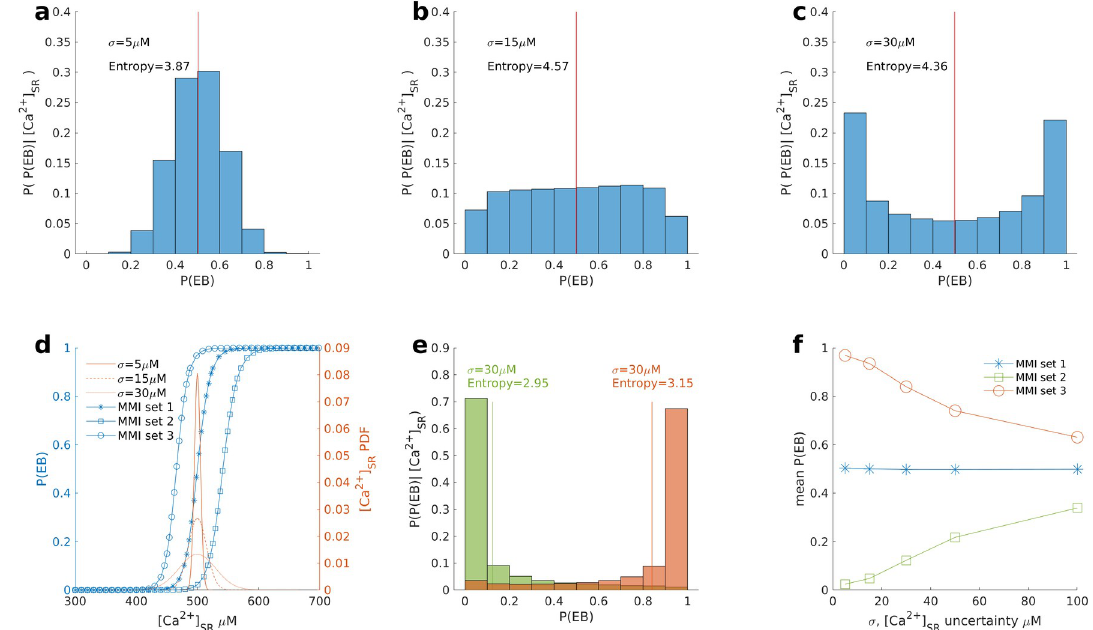
Fig 3. Uncertainty analysis of P(EB) due to variation in [Ca 2+ ] SRini . Three MMI sets are used. All MMI sets have [Ca 2+ ] iini = 150 nM, [Ca 2+ ] SRini = 500 μ M, and k RyR+ _sf = 1. G K1 _sf for set 1, set 2, and set 3 is 0.338, 0.638, and 0.000, respectively. The P(EB) distributions given different hypothetical [Ca 2+ ] SRini uncertainties ( σ ) of set 1, where (A) σ = 5 μ M, (B) σ = 15 μ M, and (C) σ = 30 μ M. The vertical red line is the mean of the P(EB) distribution. P(P(EB)|[Ca 2+ ] SRini ), on the y-axis, refers to the P(EB) distribution given [Ca 2+ ] SRini uncertainty. (D) Red curves are the [Ca 2+ ] SRini PDFs for σ = 5 μ M (solid line), σ = 15 μ M (dashed line), and σ = 30 μ M (dotted line). Blue curves are the model characteristic (MC) curves relating [Ca 2+ ] SRini and P(EB) for set 1 (stars), set 2 (open squares), and set 3 (open circles). (E) P(EB) distributions with [Ca 2+ ] SRini uncertainty σ = 30 μ M for set 2 (green bars) and set 3 (red bars). (F) Relationship between mean P(EB) and [Ca 2+ ] SRini uncertainty for all three sets.